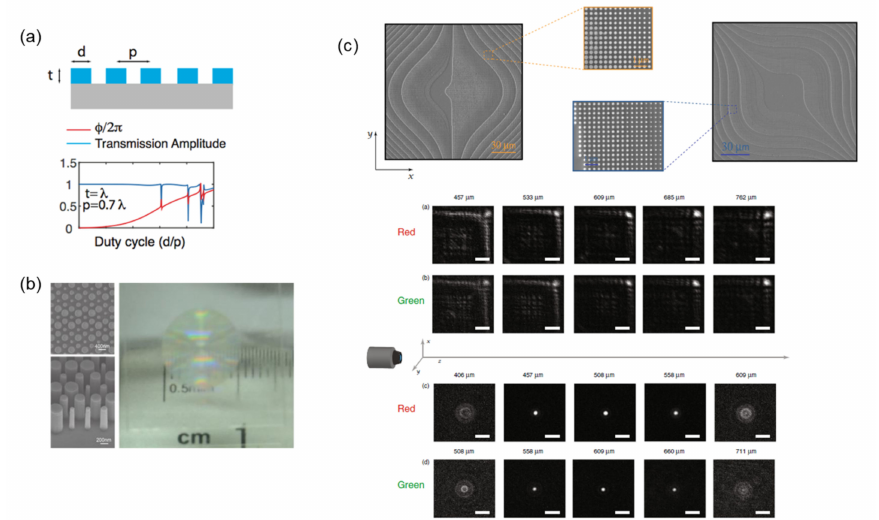
Figure 6. ( a ) Grating structures (top) with periodicity p can be formed by using cylindrical posts (with diameter d) arranged in a square lattice. The thickness of the grating is denoted as t. The thickness t was λ , and periodicity p was 0.7 λ [75]. ( b ) Top-view SEM image (left) of a portion of the fabricated micrometalens with the grating constructed using a low-refractive-index SiN x metalens with circular nanopillars on a fused silica substrate. The hexagonal lattice constant is a = 416 nm, and the thickness of nanopillars is 695 nm. Photograph (right) of the macroscopic metalens with a focal length of − 4 mm [181]. ( c ) SEM images of half of the Alvarez lens (upper left), the cubic phase plate coated in gold (upper right), PSFs of the cubic element under coherent illumination using red and green light (top middle), and PSFs of a 500- µ m metasurface lens under red and green illumination (bottom middle)